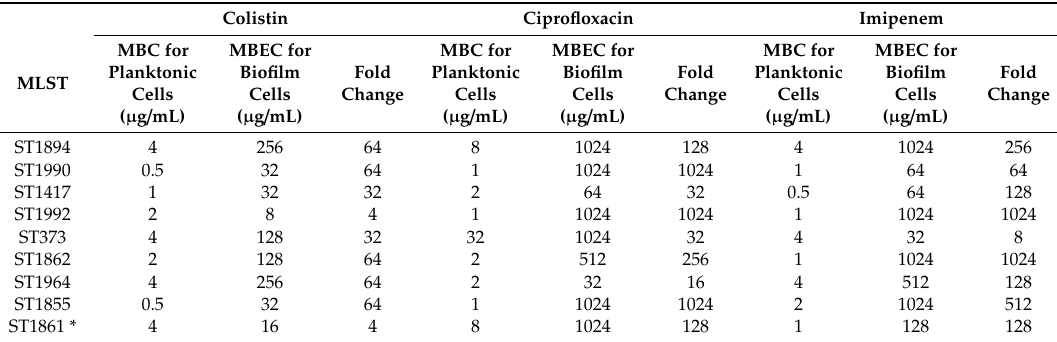
Table 6. Comparison of MBC and MBEC of A. baumannii of di ff erent